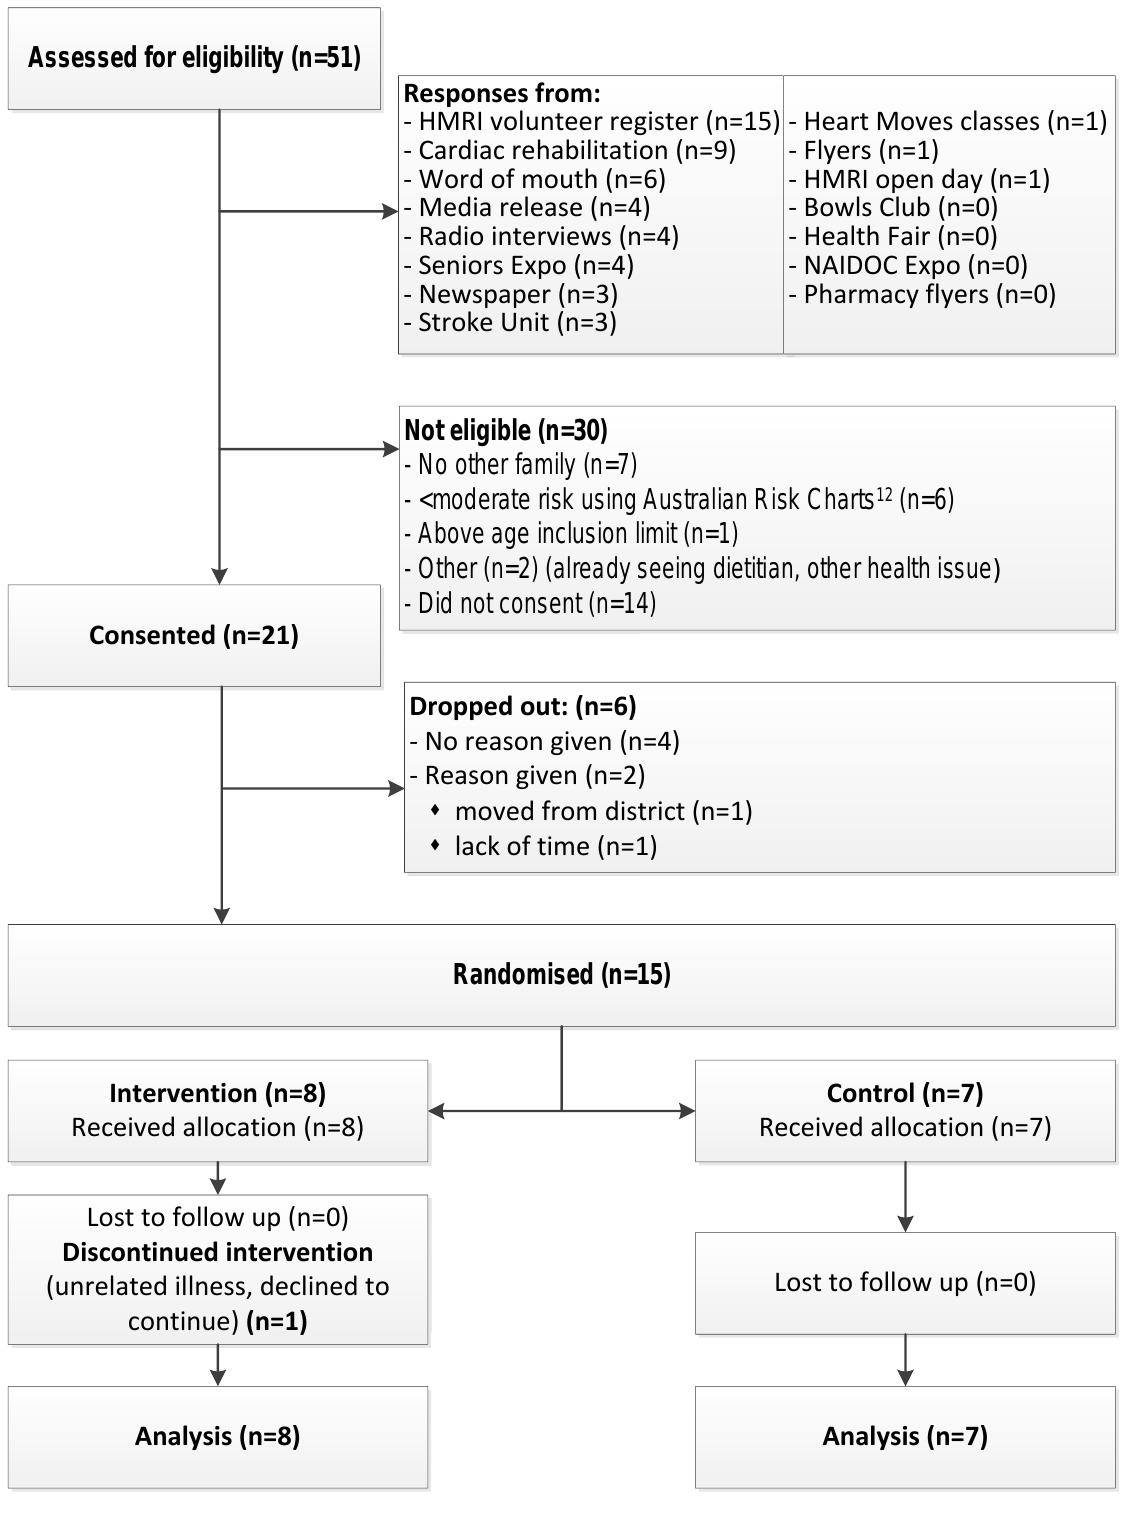
Figure 2. Flow chart showing the recruitment strategies used and number of participants assessed for eligibility and study retention.